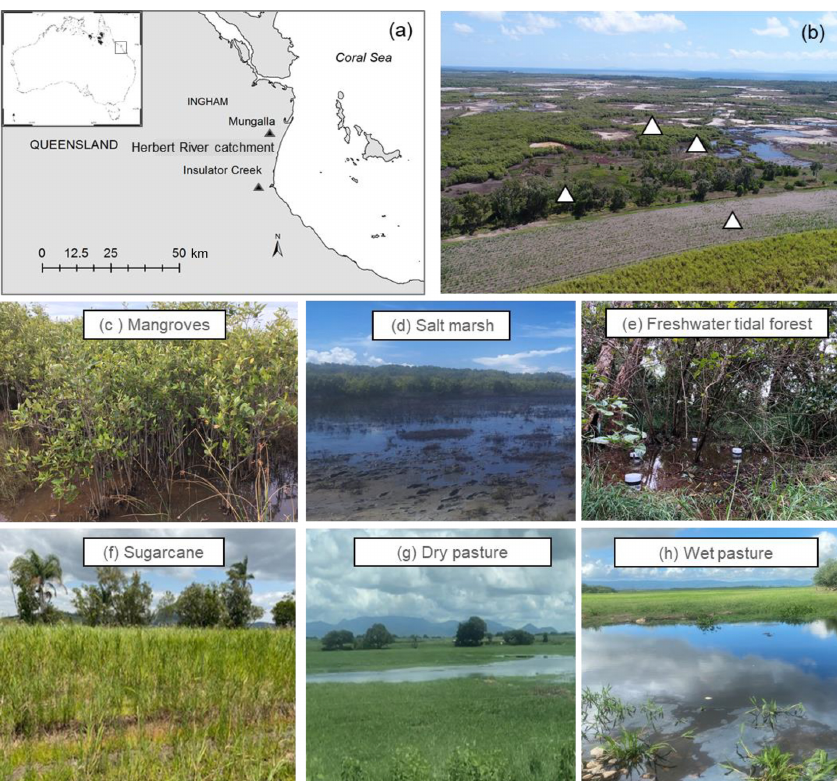
Figure 1. (a) Location of sampling sites (Insulator Creek and Mungalla) in the Herbert River catchment, northeast Australia; (b) natural wetlands adjacent to sugarcane in Insulator Creek and sampling locations; and (c) mangroves, (d) salt marsh, (e) freshwater tidal forest, (f) sugarcane, (g) dry pasture, and (h) wet pasture. Pictures by Naima Iram and Maria Fernanda Adame. Table 1. Mean daily air temperature and rainfall range (Ingham, weather station 32078) during sampling. Season Study period Daily min Daily max Rainfall temperature ( ◦ C) temperature ( ◦ C) (mmd − 1